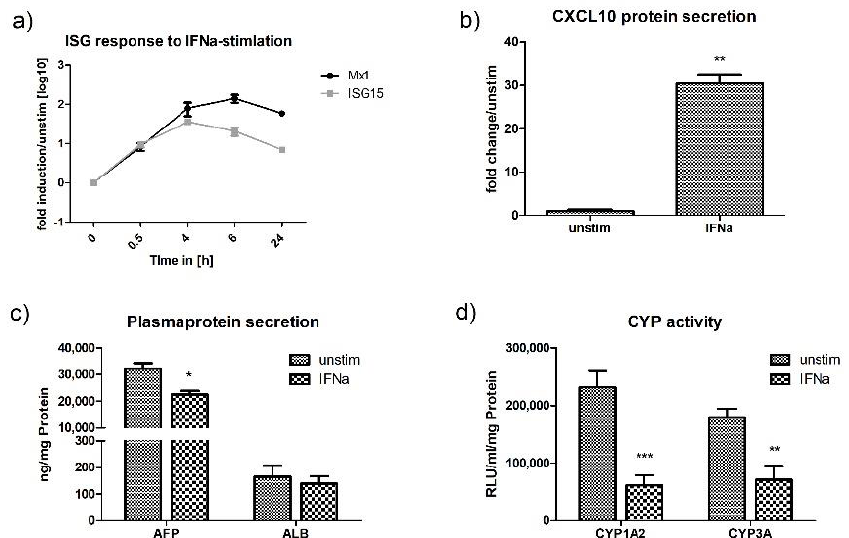
Figure 6. IFN- α induces anti-viral activity in P106-HLCs, which is accompanied by an immunometabolic switch. ( a ) P106-HLCs demonstrate strong innate immune activity upon stimulation with IFN- α . Stimulation with IFN- α induced ISG-expression (ISG15, Mx1) in a time-dependent manner, as determined by qPCR ( N = 3). ( b ) Expression of CXCL10 protein upon IFN- α stimulation. Stimulation with IFN- α induced CXCL10 protein expression as determined by ELISA at the 24 h time point ( N = 3). ( c ) E ff ect of innate immune activation on hepatocytes metabolic activity. Cells were stimulated with IFN- α for 16 h before CYP-activity and plasma protein production was measured and compared with unstimulated cells. The generation of an inflammatory environment as determined by upregulation of cytokines and chemokines was accompanied by the downregulation of plasma protein production (AFP, ALB) and ( d ) cytochrome P450 (CYP1A2, CYP3A) in order to redirect intracellular energy into defense strategies ( N = 3). Results are shown as mean +/ − SEM. * p < 0.05, ** p < 0.01, and *** p < 0.001. IFN = interferon, ISG = interferon stimulated genes, CXCL10 = C-X-C motif chemokine 10, AFP = alfa fetoprotein, ALB = albumin, CYP = cytochrome P450.